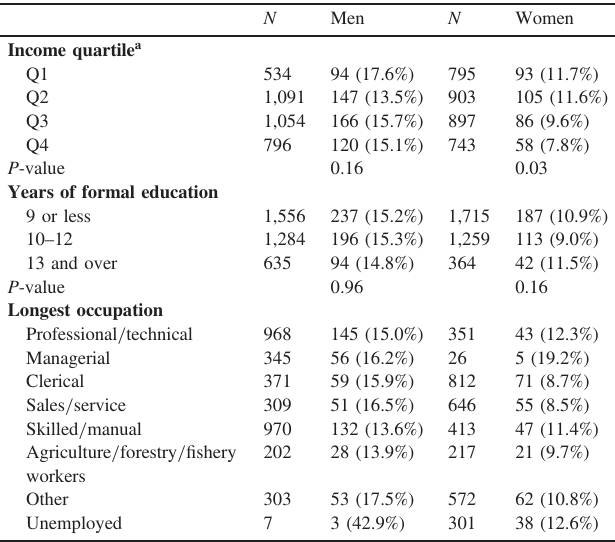
P -values were calculated using Chi-squared test. a Income quartile calculated by all participants in JAGES2010 ( ‘ Low ’ – 1.250, ‘ Middle-low ’ 1.251 – 1.944, ‘ Middle-high ’ 1.945 – 3.061, ‘ High ’ 3.062 – million yen per year).